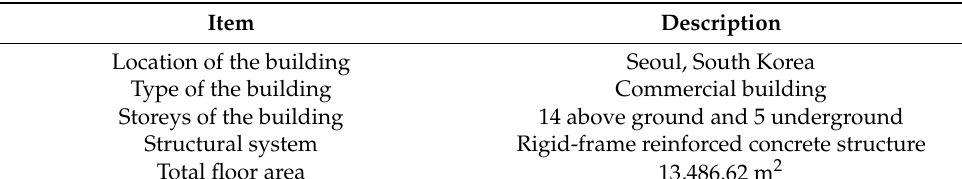
Table 2. The profile of the case study building.